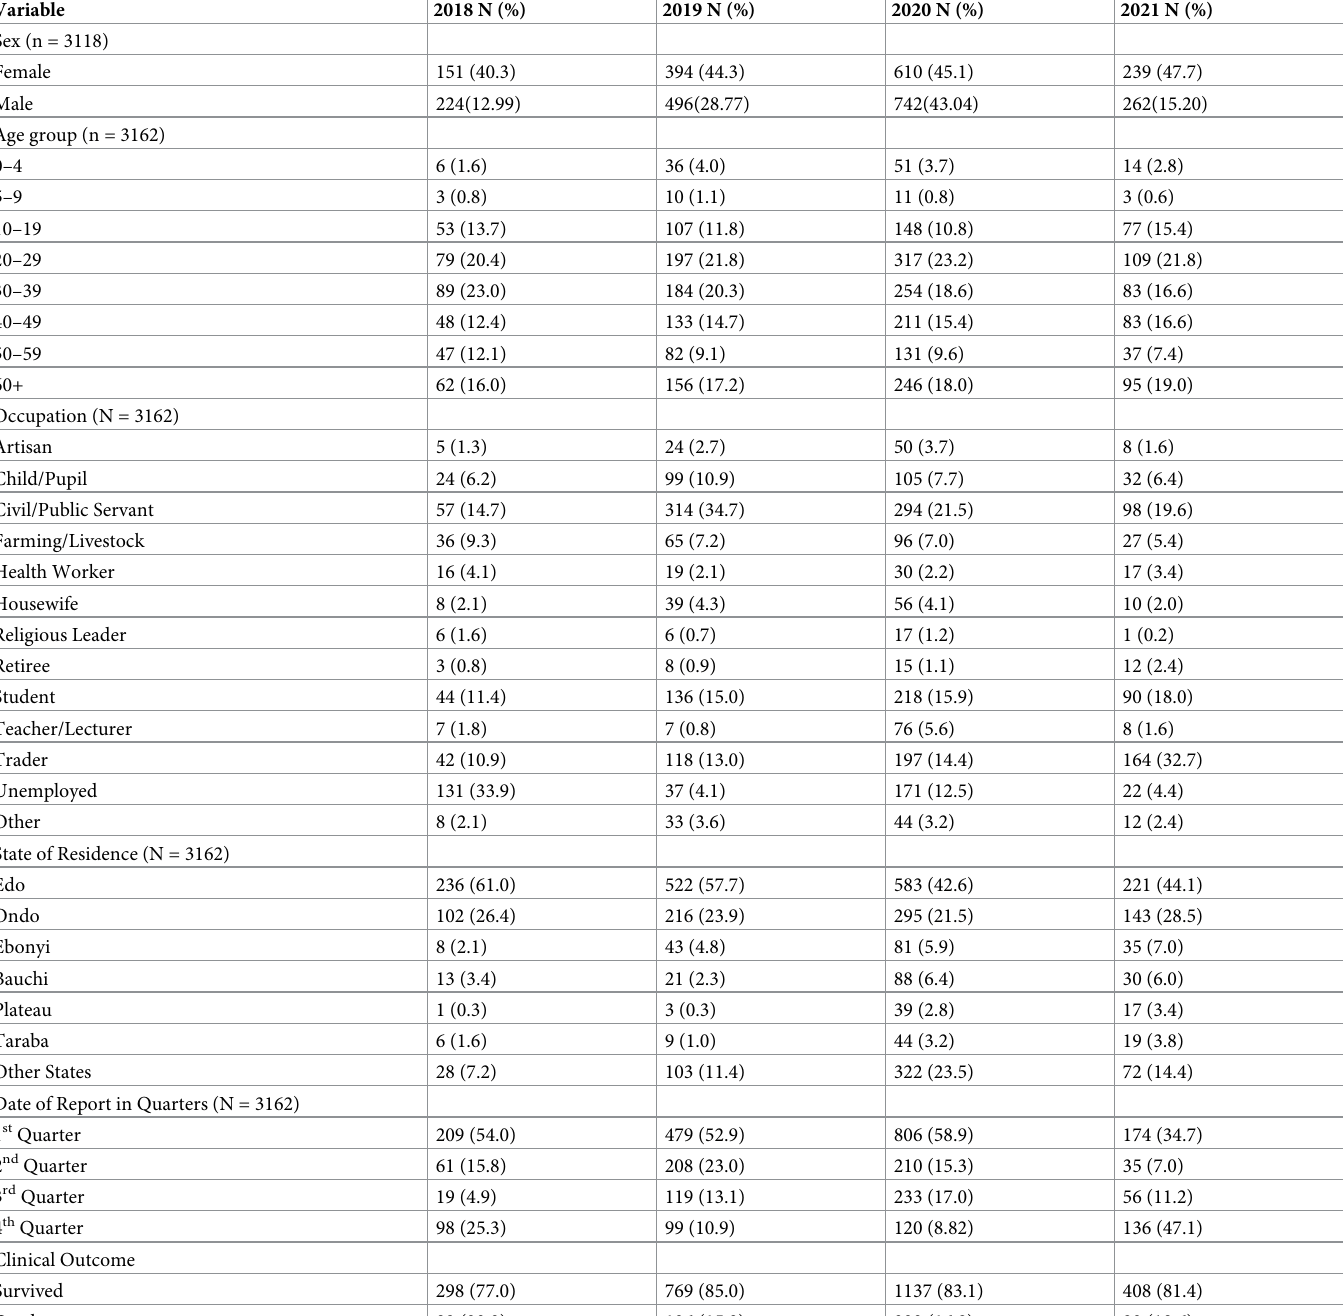
Table 1. Sociodemographic characteristics of confirmed cases,